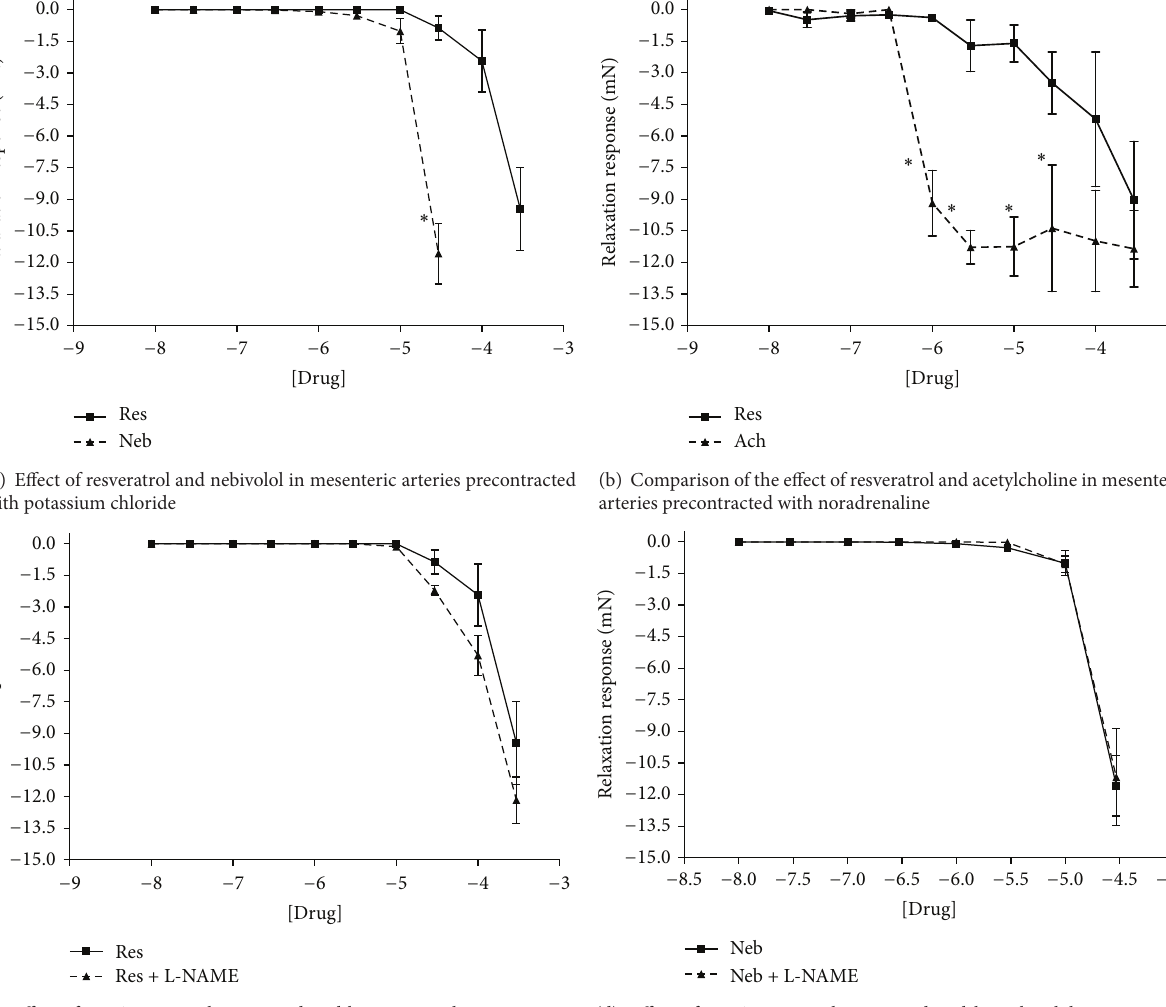
(d) Effect of L-NAME on relaxation induced by nebivolol in mesenteric arteries precontracted with potassium chloride Figure 3: Relaxation responses induced by the addition of either resveratrol or nebivolol in isolated segments of mesenteric arteries. Res: resveratrol; Neb: nebivolol; Ach: acetylcholine; L-NAME: N 𝜔 -nitro-L-arginine-methyl-ester. ∗ 𝑃 < 0.05 , data presented as mean ± SEM; 𝑛 = 3 – 6